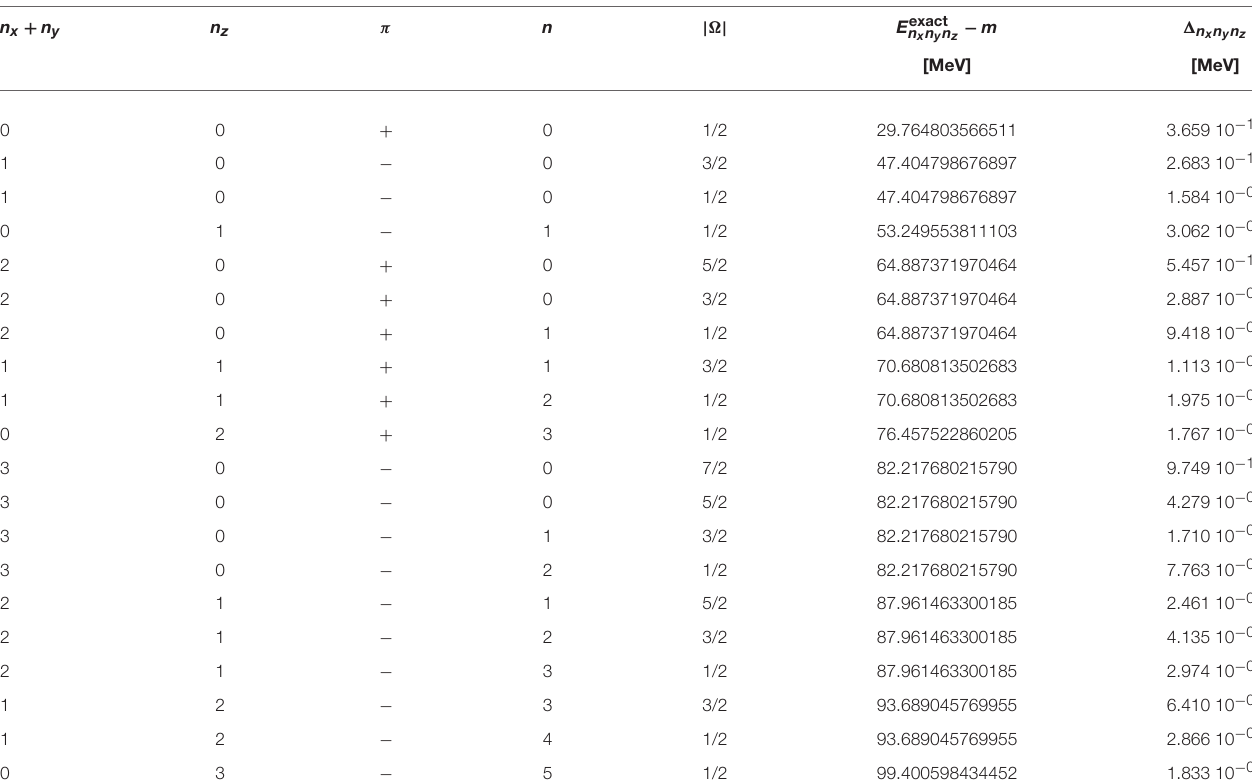
0.1, - h ω 20 MeV, and m 938 MeV/ c 2 and absolute deviation (88) of = − = = 0.1 fm, number of grid points N 25, and number of channels N c = = =